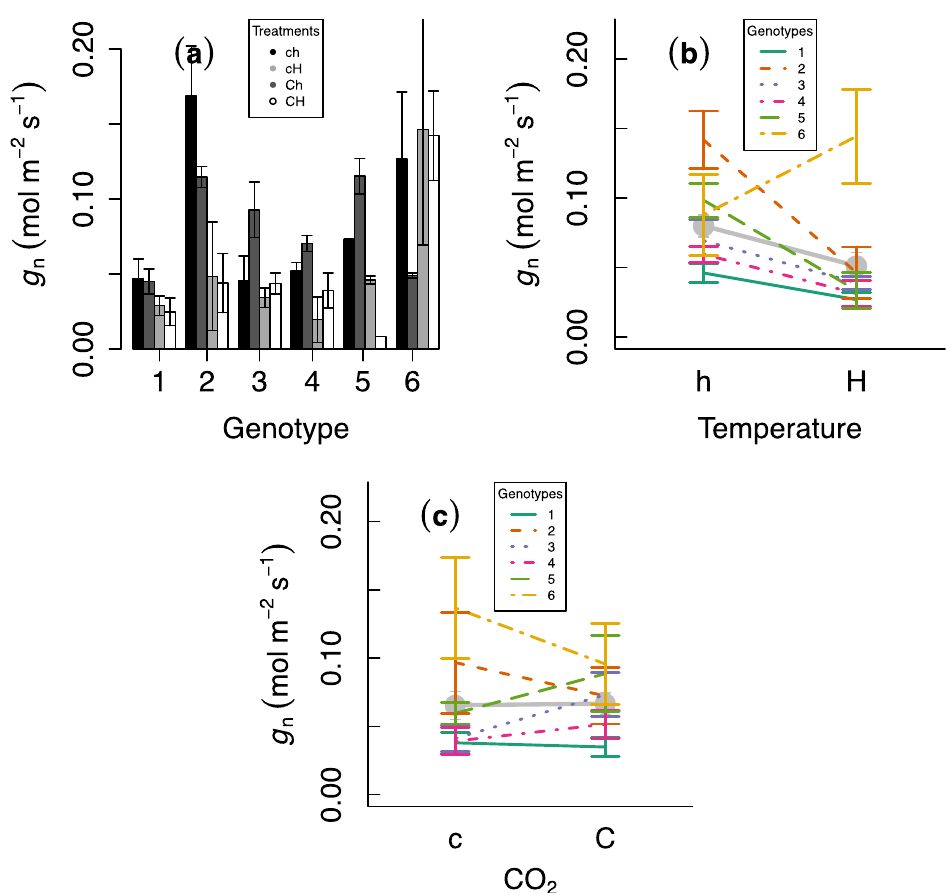
Figure 1. Experimental responses of nocturnal stomatal conductance. ( a ) Variation across genotypes as a function of heat-wave exposure and CO 2 concentrations. ( b ) Reaction norms of heat-wave responses across genotypes. ( c ) Reaction norms of CO 2 responses across genotypes. Grey in ( b , c ) indicates average values for all genotypes and the other colors indicate individual genotypes. h, H, c and C indicate no heat-wave exposure, heat-wave exposure, ambient CO 2 , and elevated CO 2 , respectively. Error bars indicate standard errors.